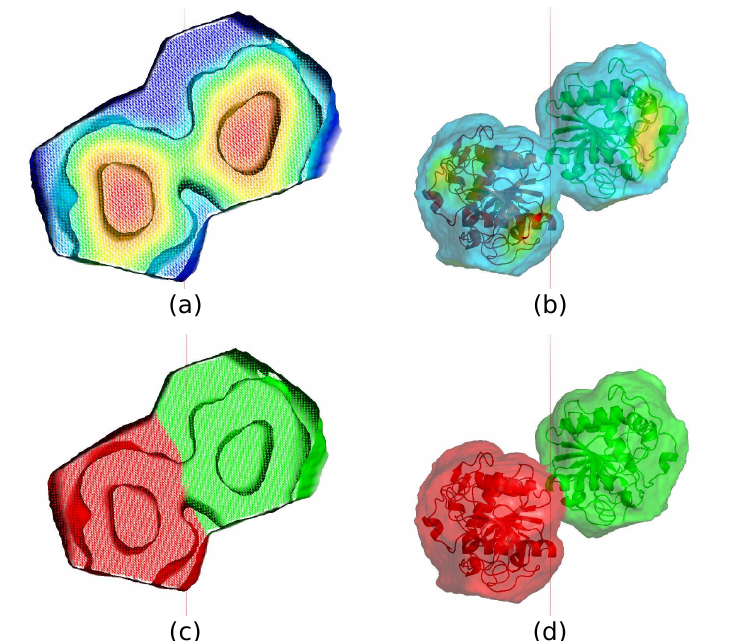
Figure 15. ( a , b ) Show the constructed dimer core, ASU, and protein boundary of 5AP9. Warm colors in ( a , b ) represent high weighted average density. ( c , d ) Show the monomers.